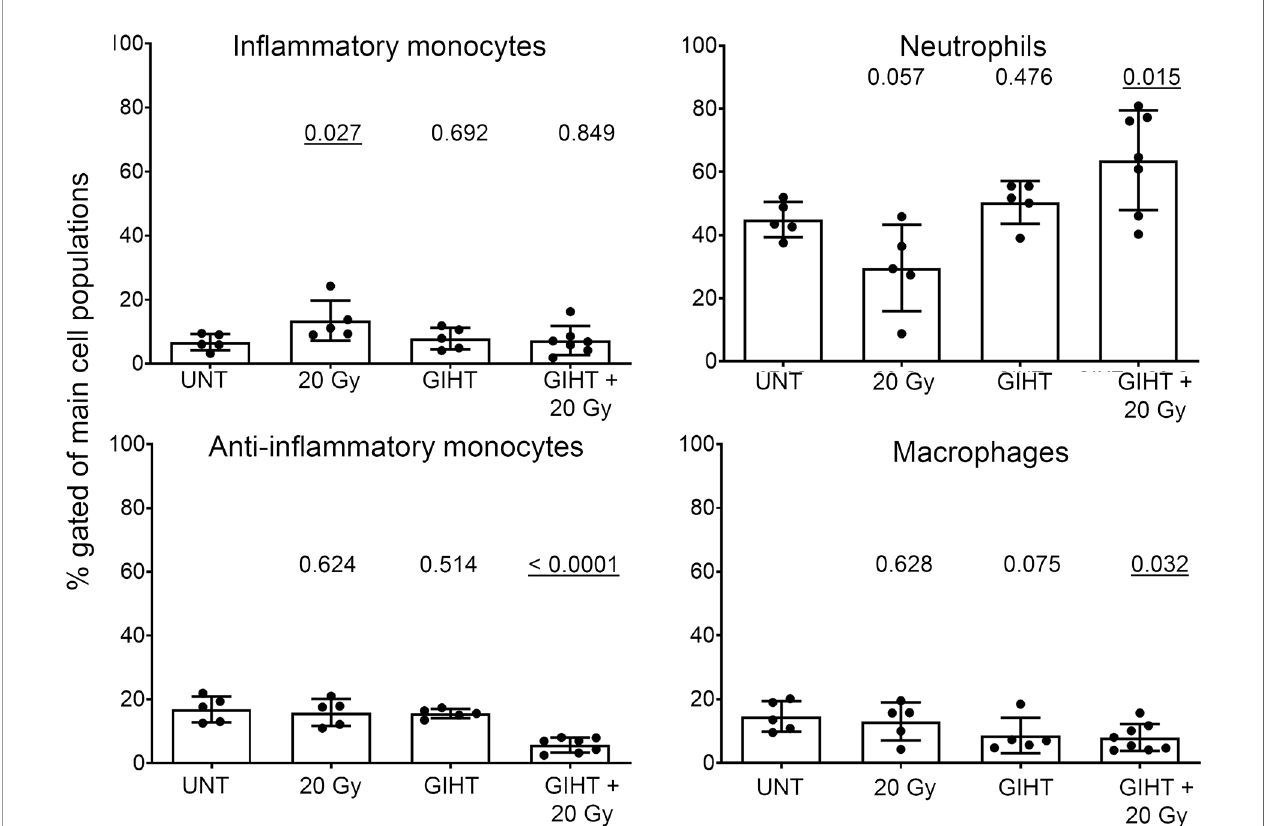
FIGURE 3 | In fl ammatory cell in fi ltration to the site of cell death. SNs of dying B16F10 melanoma cells (24h) were injected into air pouches of mice and the in fi ltrating cells were quanti fi ed by fl ow cytometry. The in fi ltration caused by supernatants of untreated cells was used as a baseline. The main four myeloid populations are shown. One-way analysis of variances of fi ve mice with Tukey ’ s multiple comparison test is shown. Values of p < 0.05 considered as signi fi cant are underlined. UNT, untreated; Gy, Gray; GIHT, graphene-induced